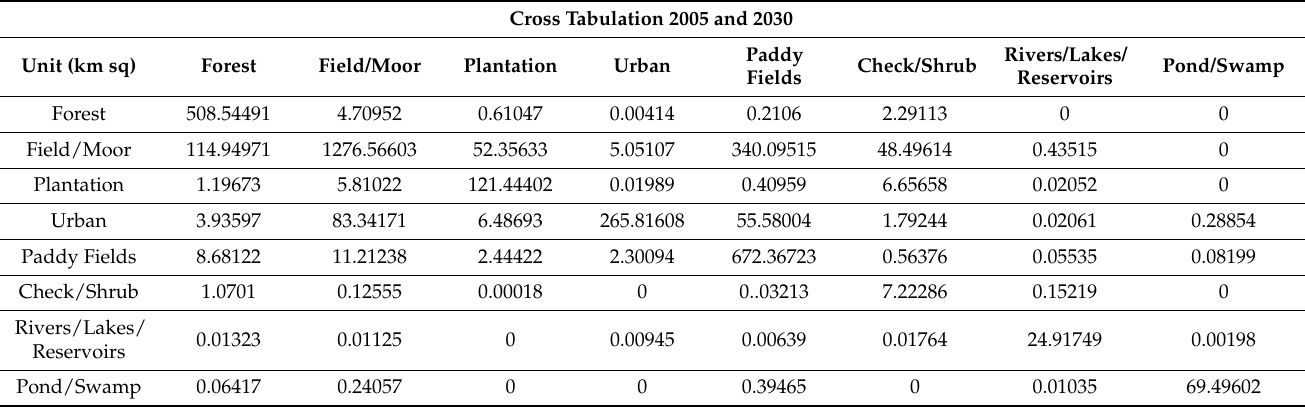
Table 4. The crosstabulation table for land cover predictions in West Java in 2030. Cross Tabulation 2005 and 2030